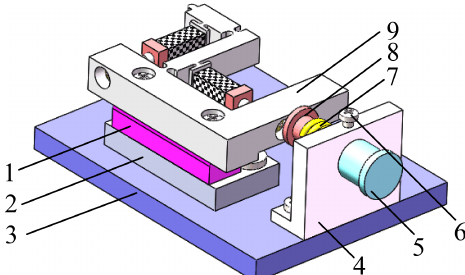
Figure 5. Diagram of pre-tightening mechanism: (1) slideway, (2) padding block, (3) baseplate, (4) pre-tightening supporting plate, (5) pre-tightening adjusting column, (6) locking screw (7) pre- tightening spring, (8) pre-tightening block, and (9) stator with dou- ble driving feet.